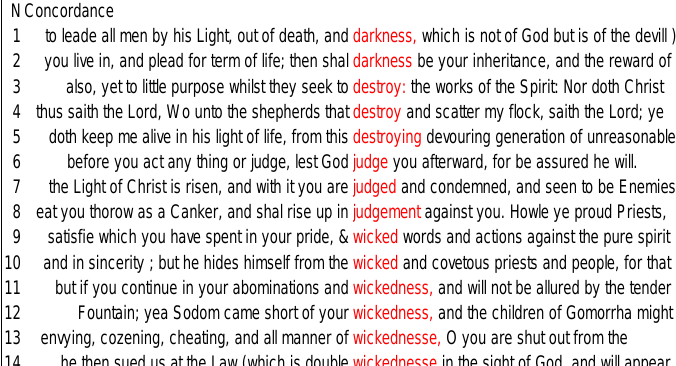
Figure 2. Example concordances lines, in Qcorpus1 for: DARK, DESTROY, JUDGE, and WICKED.